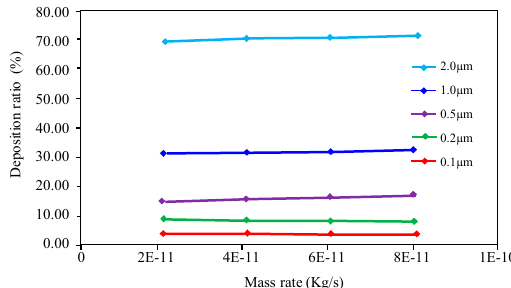
Figure 3. Deposition rate of sulfur particles with different diameters at different gas mass flow rates.